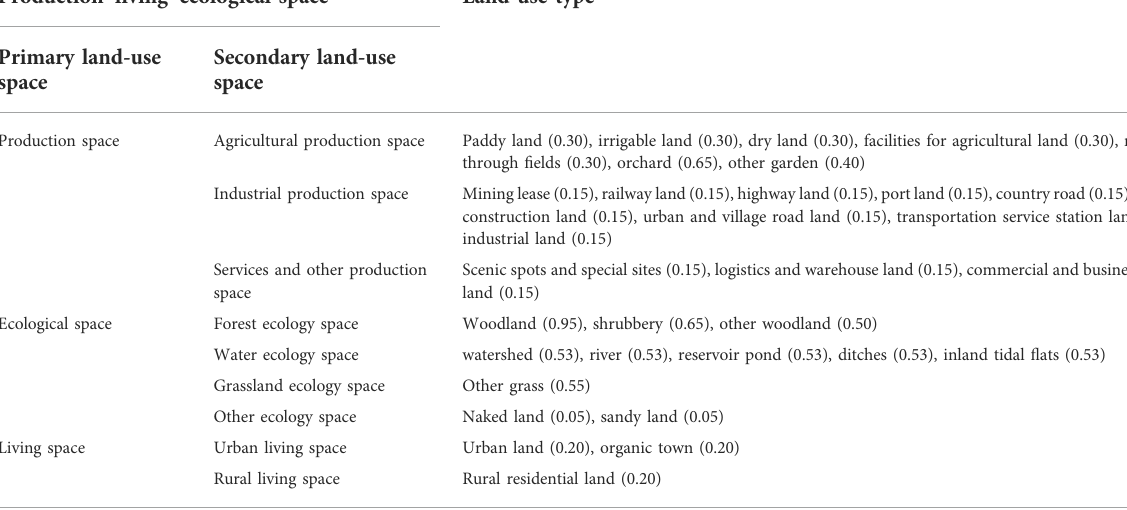
TABLE 1 Production – living – ecological space classi fi cation and ecological weight assignment. Production – living – ecological